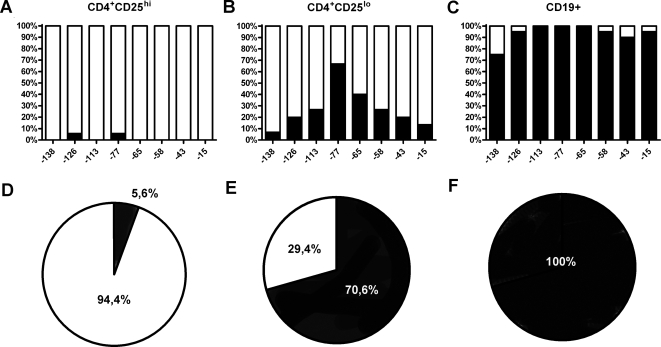
Tregs are unmethylated at the FOXP3 promoter region.Bars in (A) to (C) indicate the percentage of methylated (black) and unmethylated (white) cells at each CpG position (specified on x-axis labels as relative the transcription start site) in (A) CD4+CD25hi, (B) CD4+CD25lo and (C) CD19+ cell populations isolated by FACS from one male donor. (D) to (F) Methylation grade of the most discriminating CpG position (−77). Percentage methylated (filled) versus unmethylated (open) CpGs in the (D) CD4+CD25hi, (E) CD4+CD25lo and (F) CD19+ cells.